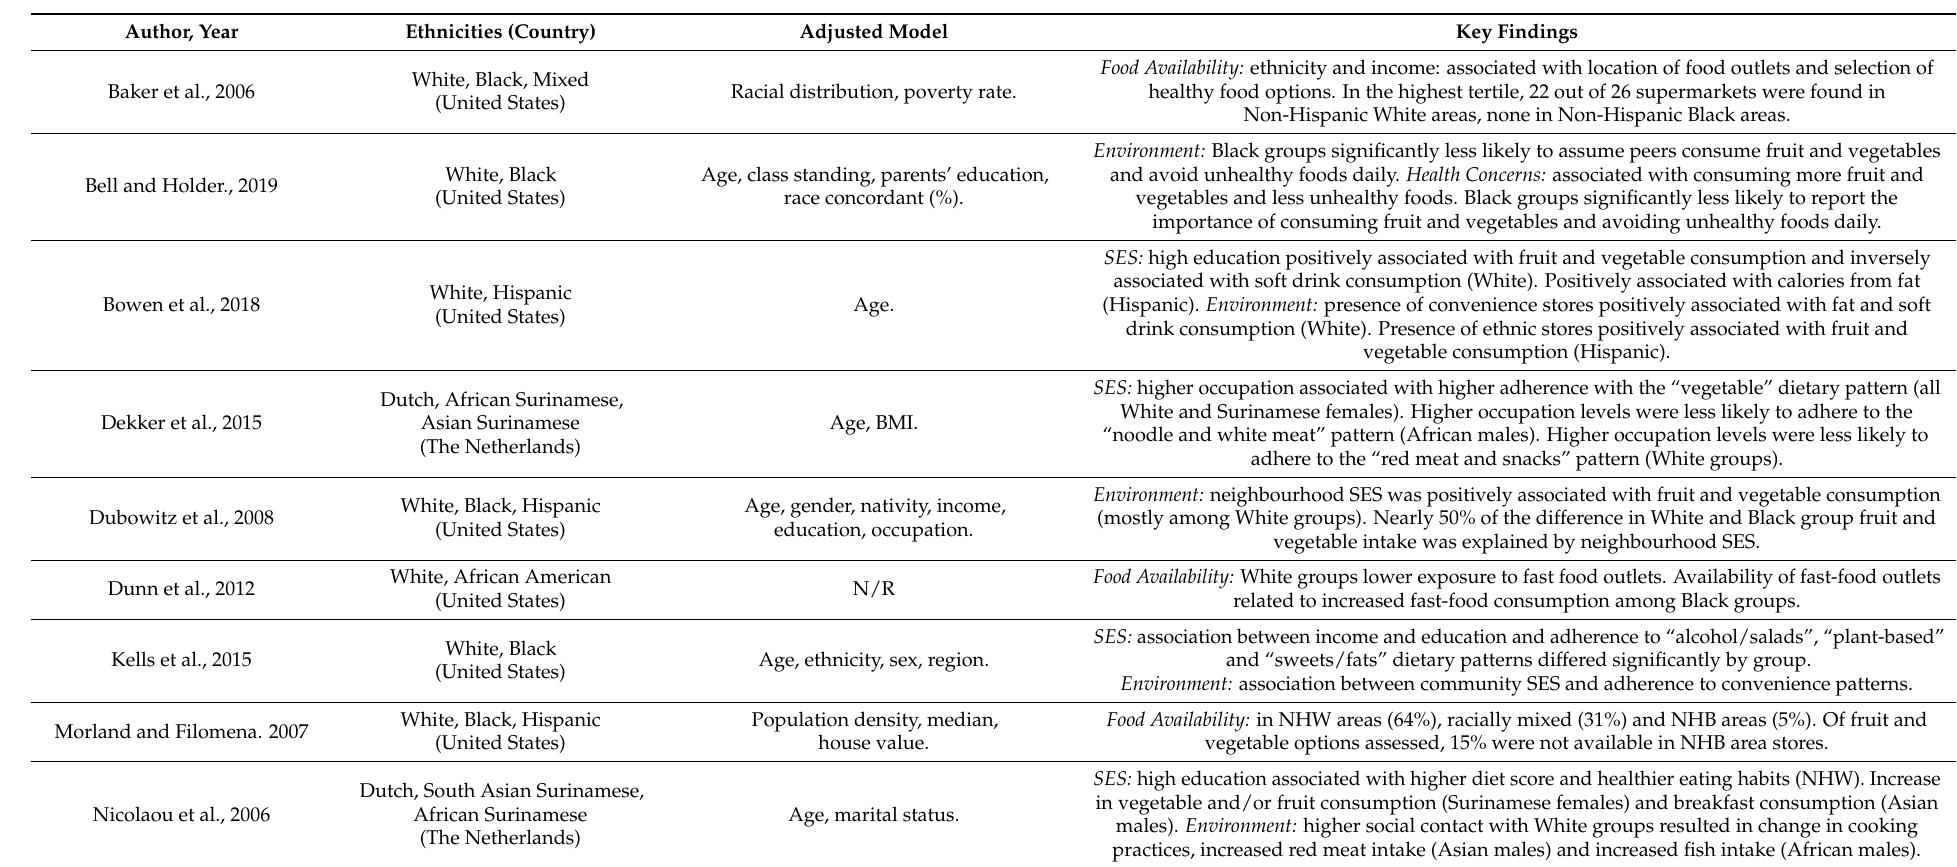
Table 4. Food choice influences of ethnic